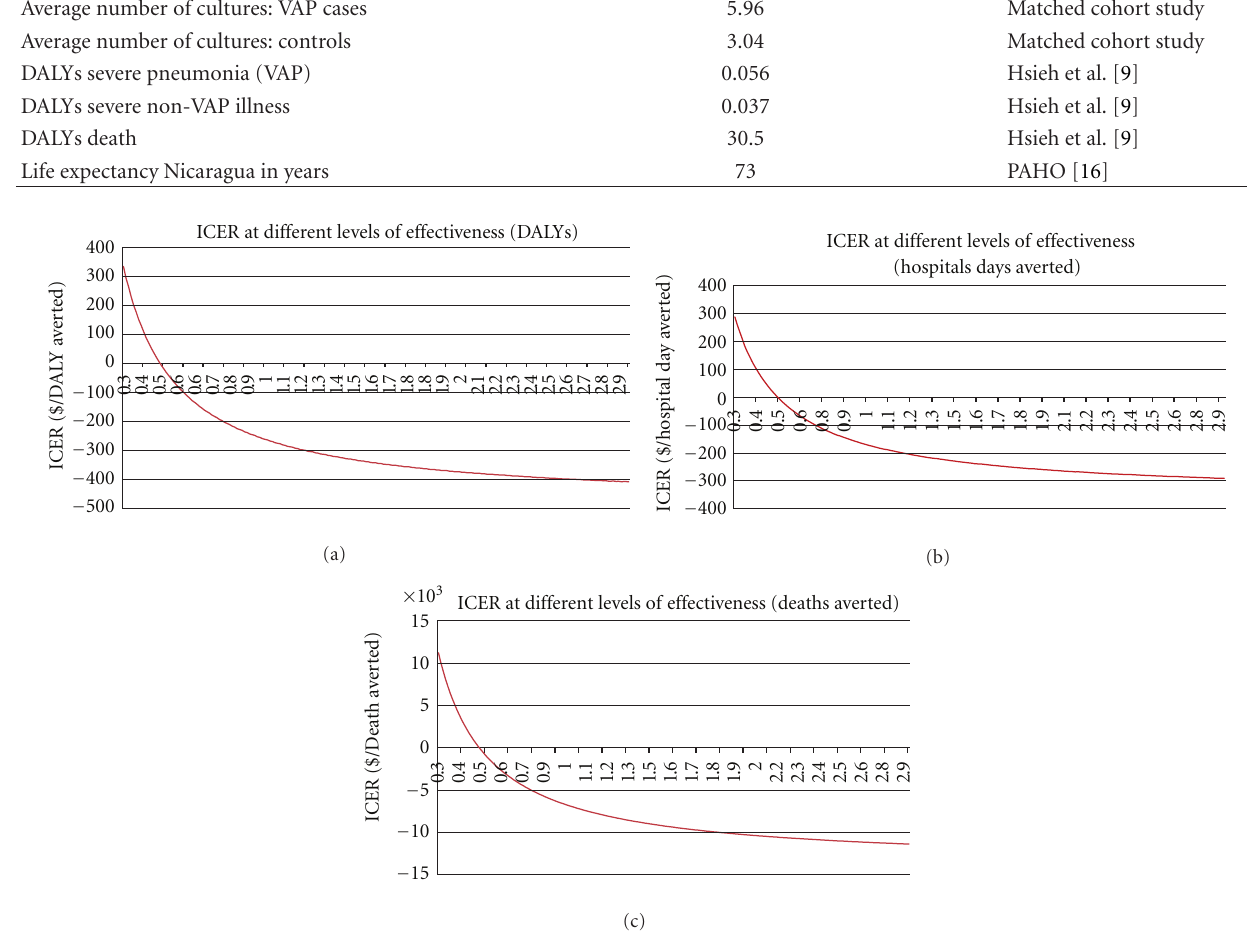
Figure 2: ICER of the QI intervention at di ff erent levels of e ff